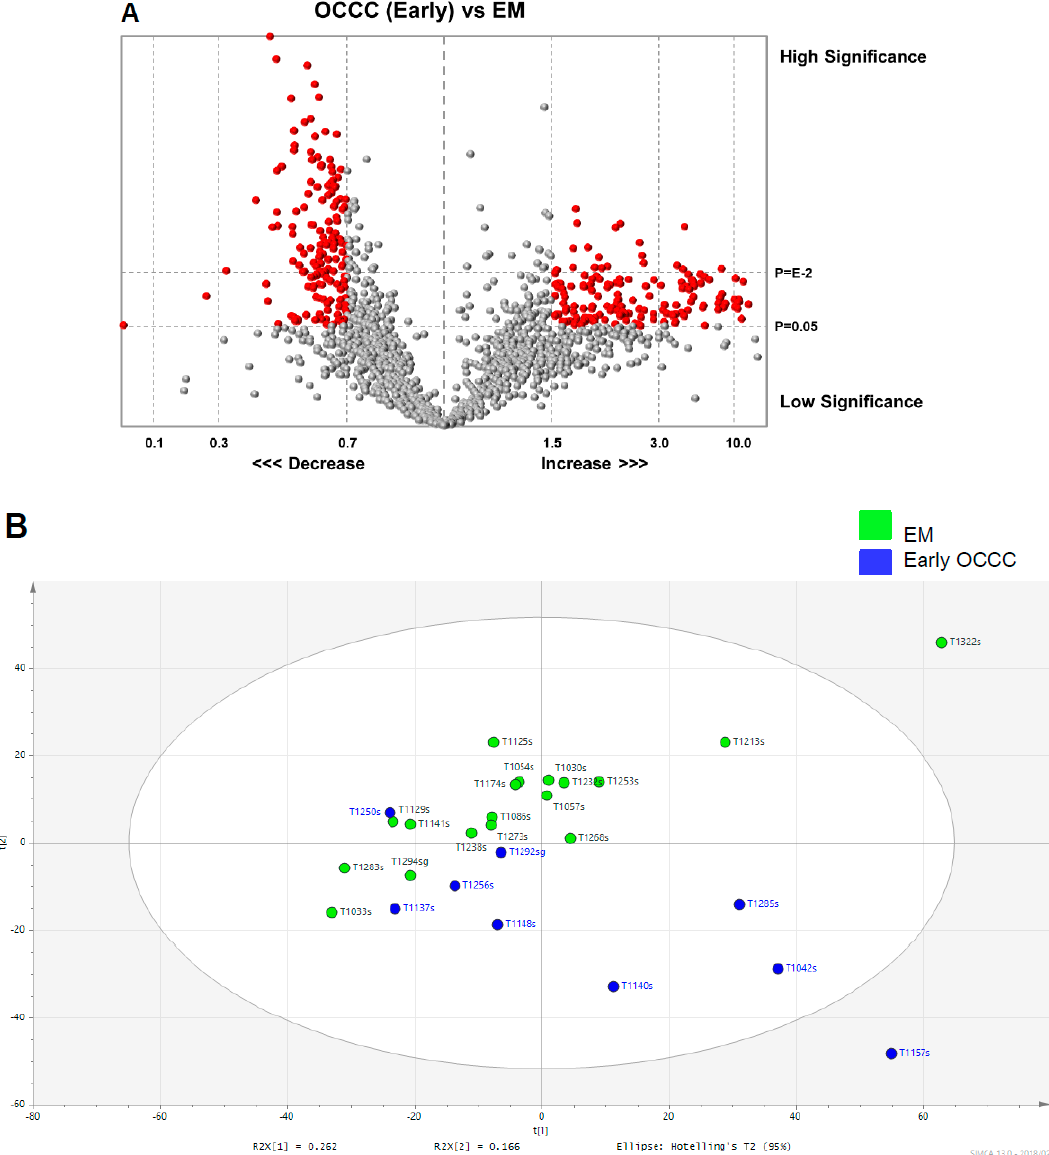
Figure 4. Glycopeptide spectral data in early-stage OCCC group and endometrioma group. ( A ) Volcano plot of serum digested glycopeptide data in early-stage OCCC n = 9 compared to 18 endometrioma patients. The Y-axis is the p -values determined by the t -test of the mean fold change and the X-axis is the mean fold change. The red dots in the plot represents the di ff erentially expressed glycopeptides with statistical significance ( p < 0.05) and mean fold change of < 0.7 or > 1.5. The vertical lines in the matrix represent the log 2 fold changes and the horizontal lines in the matrix represent the statistical significance of p < 0.05. ( B ) PCA scatter plot of endometrioma (green dots) and early-stage OCCC patient (blue squares) serum samples. The ellipse represents 95% confidence interval. Abbreviations: OCCC, ovarian clear cell carcinoma; and EM,